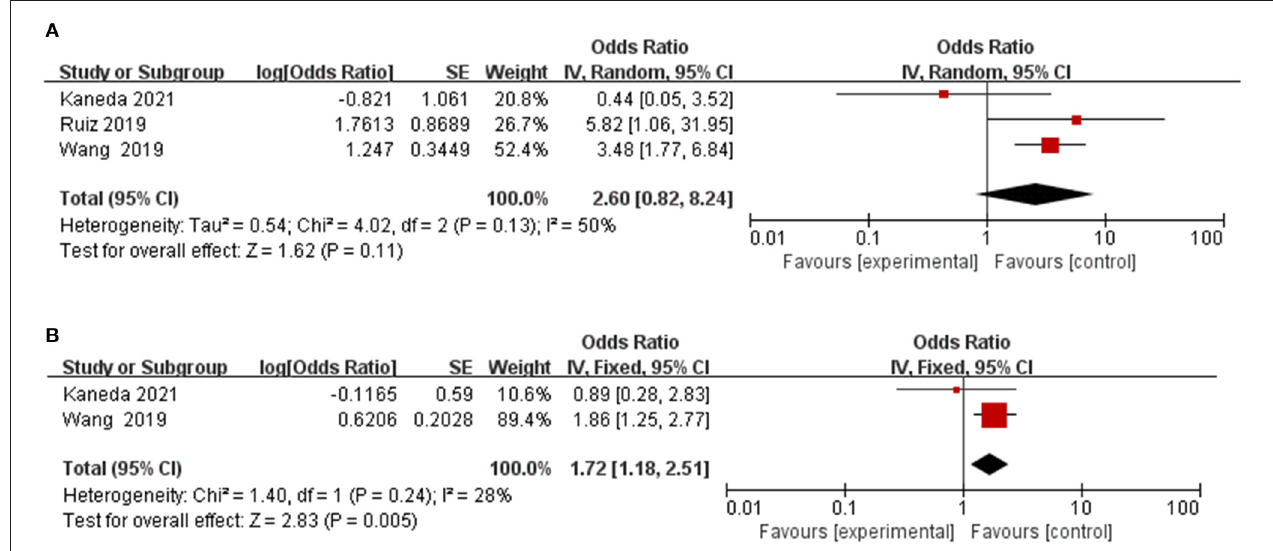
FIGURE 4 | Forest plot of the association between frailty and therapeutic toxicity. (A) frailty and therapeutic toxicity; (B) prefrailty and therapeutic